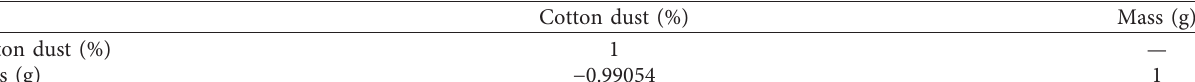
Table 9: Correlation data analysis for the mass of brick samples.